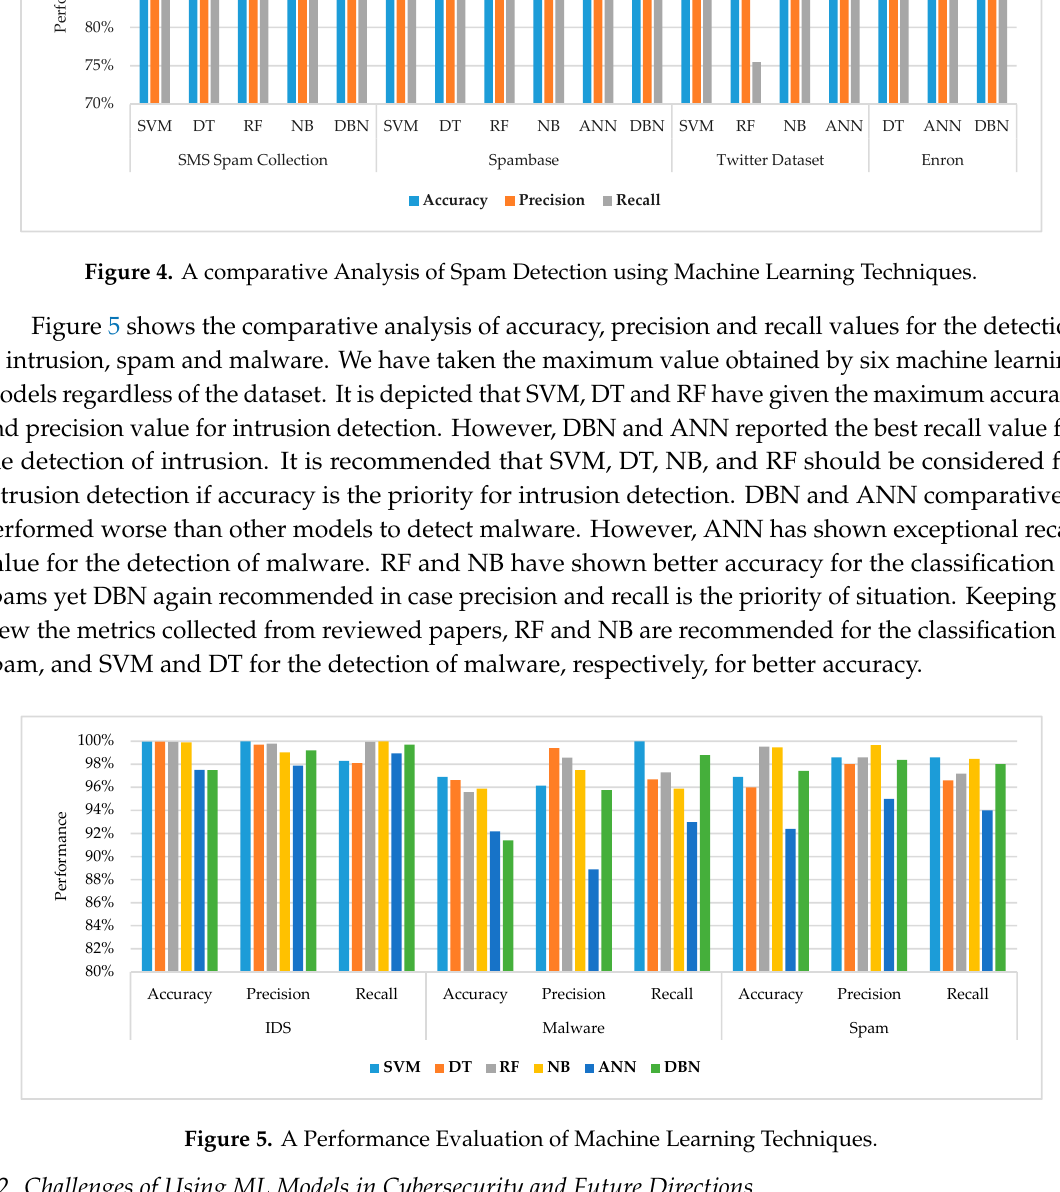
Figure 3. A comparative Analysis of Malware Detection using Machine Learning Techniques.